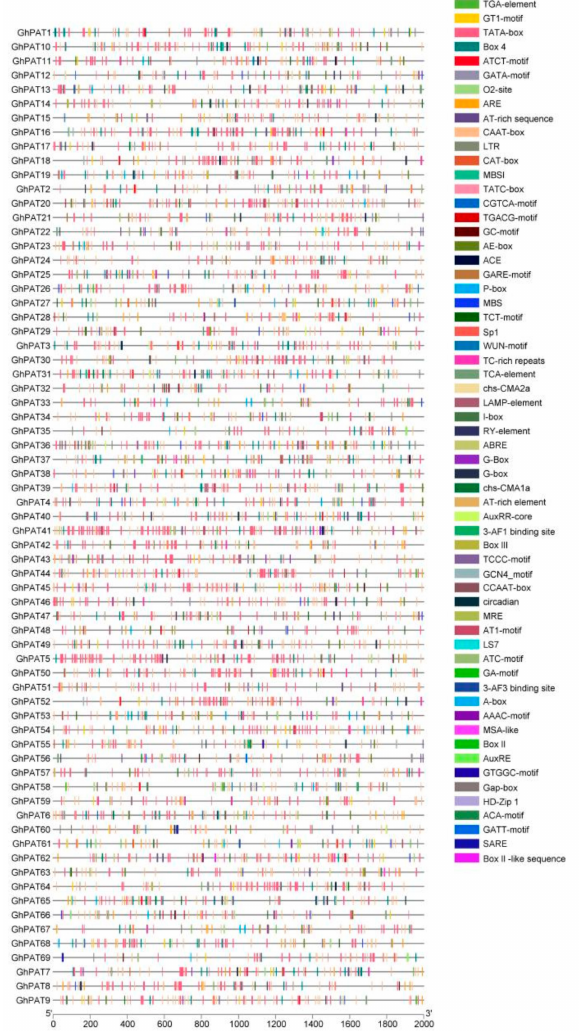
Figure 5. Cis-elements of GhPAT